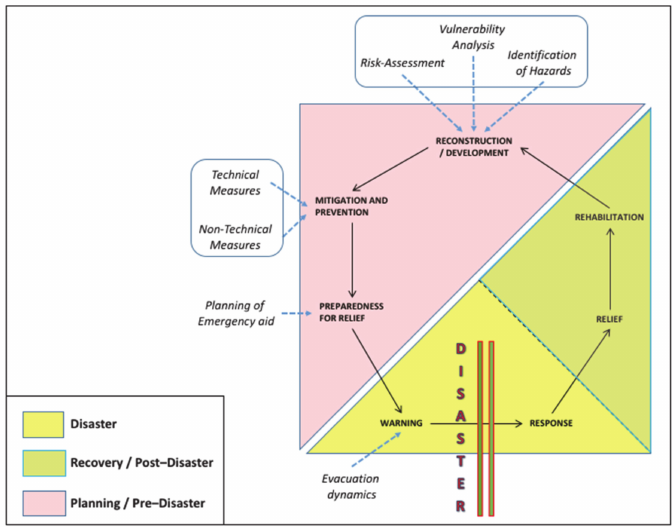
Figure 1. Disaster Management Cycle (elaborated from: Baird et al., 1975; Shorbi and Wan Hussin,